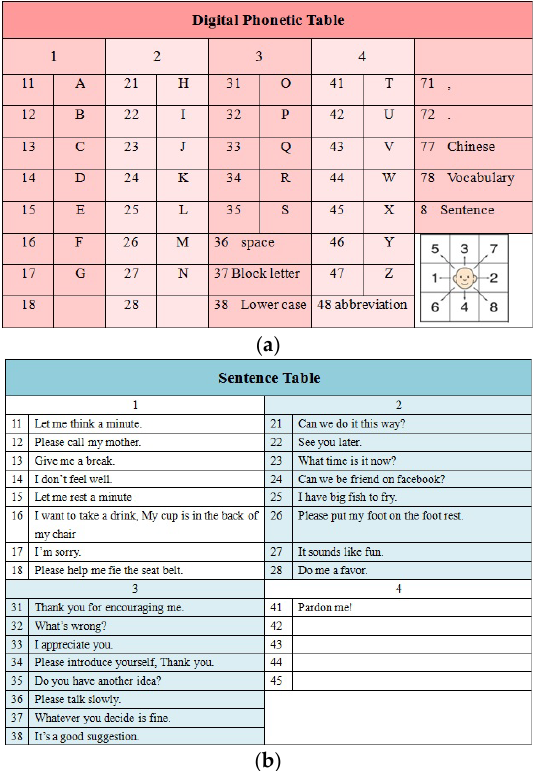
Figure 8. The numeric DT-MHIS phonetic system. ( a ) numeric English phonemicized table and ( b ) frequentation-used sentences. Table 1. Voice mapping lookup table.